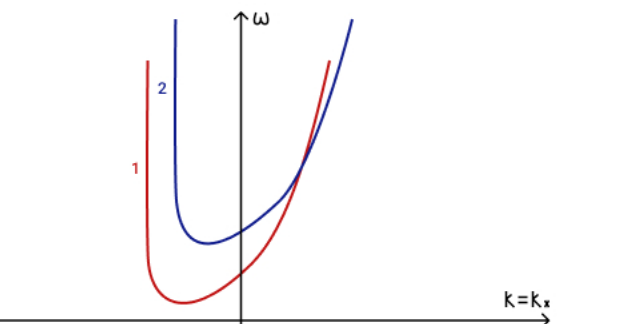
Figure 19. Phase matching condition for three magneto-Rossby waves in low-frequency approxima- tion: 1 — ω = ω ( k x ) , 2 — ω = ω ( k x − k x